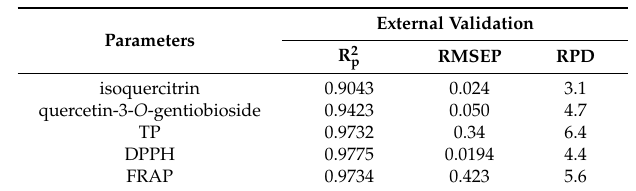
Table 3. External validation of the established partial least squares (PLS) models for antioxidant constituents and